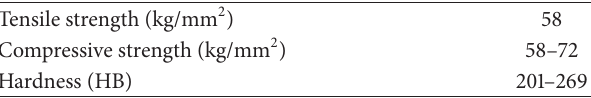
Table 2: Mechanical properties of SAE1045 medium carbon steel.